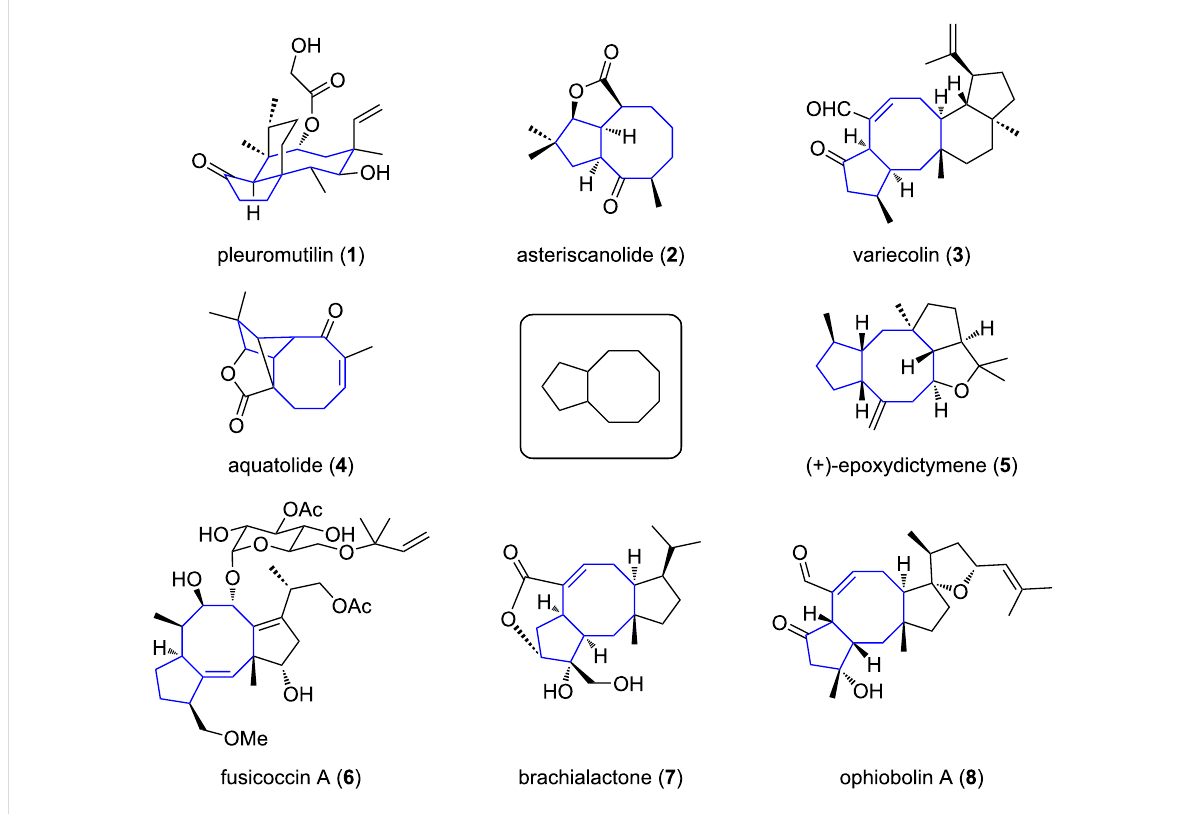
Figure 1: Examples of terpenes containing a bicyclo[3.6.0]undecane